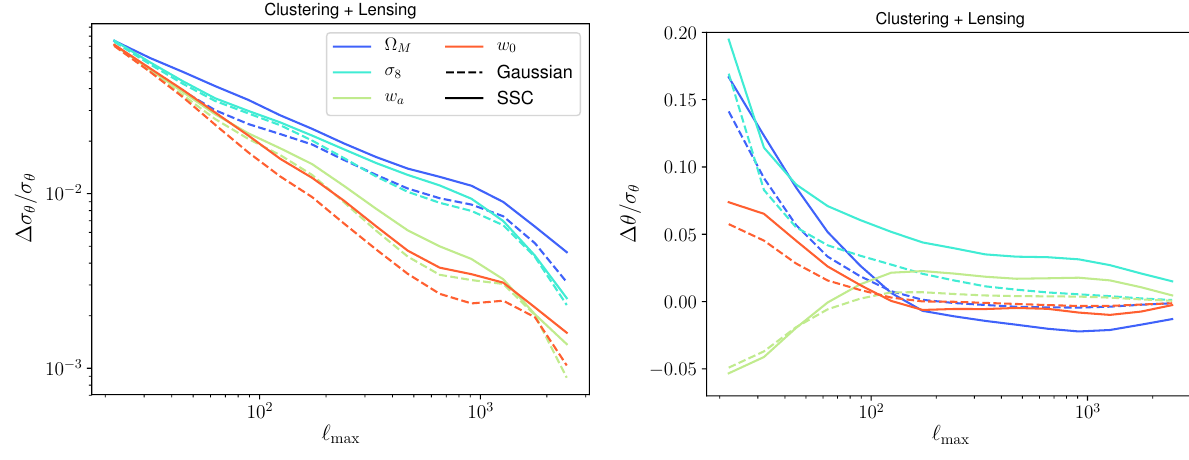
FIG. 5: Left: relative error difference due to a parameter-dependent covariance for the four cosmological parameters studied here as a function of the maximum multipole (cid:96) max included in the analysis for a fiducial sky fraction f sky = 0 . 4. Right: same as the left panel for the relative parameter bias. As expected, the impact of the parameter dependence grows as we reduce the number of independent modes used in the analysis. In all cases, the effect is smaller than 20% of the statistical uncertainties, ∼ even for (cid:96) max 20, and becomes percent-level for realistic values ( (cid:96) max ∼ ∼